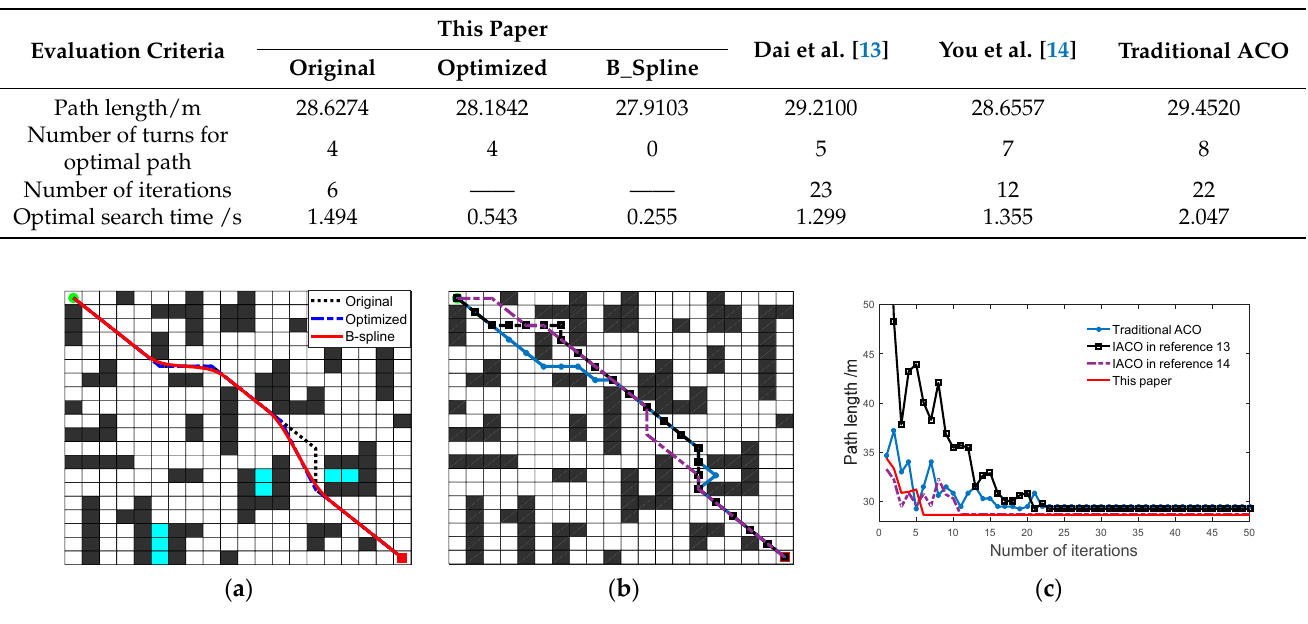
Figure 17. Comparison diagram of path planning; ( a ) Optimal path diagram of this paper; ( b ) Optimal path diagrams of other algorithms; and ( c ) Optimal path iteration